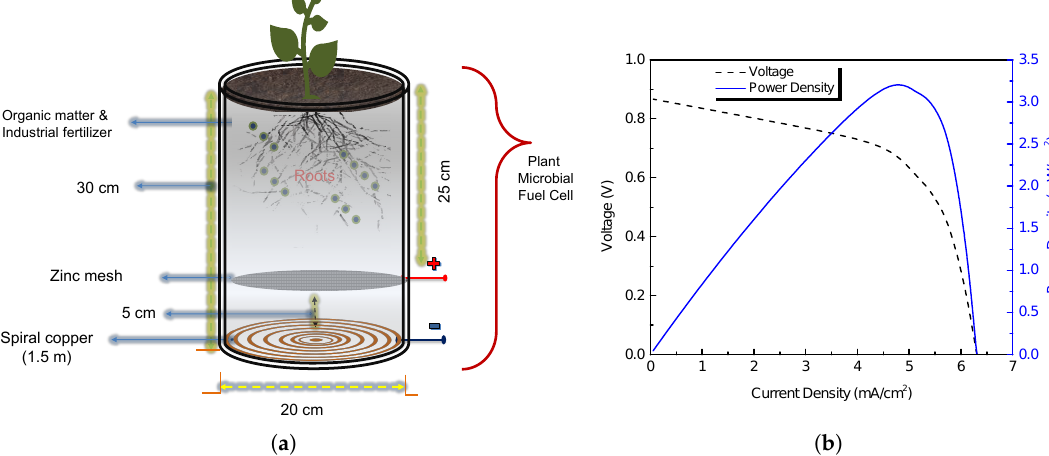
Figure 1. ( a ) Schematic representation of the proposed PMFC in the set of experiments: PMFC used with mix soil, fertilizer and the Cordyline Fruticosa plant; ( b ) Typical performance of a PMFC ( I - V and P - V characteristic